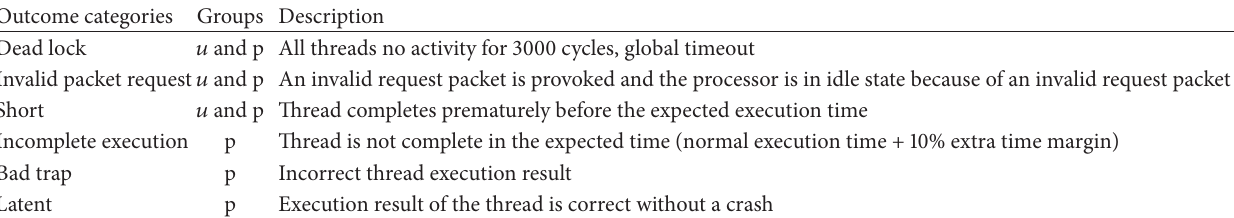
Table 8: Outcome categories